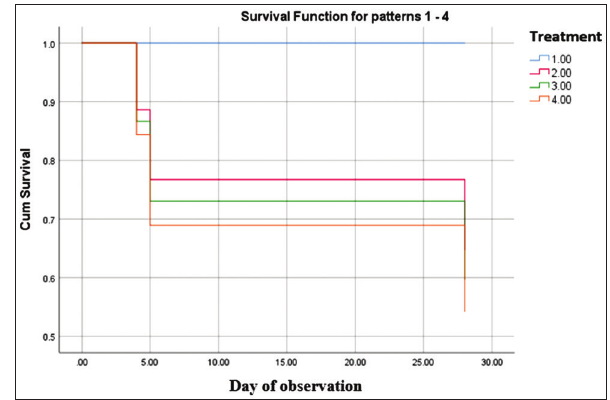
Figure-1: Survival pattern of mice in goat bile-treated groups and negative control. All mice (5) of negative control group survived (100%) within 28 days of observation. Two mice of GB100-, GB50-, and GB25-treated group died on days 4, 5 and 28, respectively, and percentages survival of those three groups were total 60%. Blue line, treatment 1: Negative control; Red line, treatment 2: GB100-treated mice; Green line, treatment 3: GB50-treated mice; Orange line, treatment 4: GB25-treated mice. Statistical analysis: Cox regression Table-1: Subacute toxicity effect of goat bile on body weight and hematology parameters in BALB/c mice. Group Parameters of mice